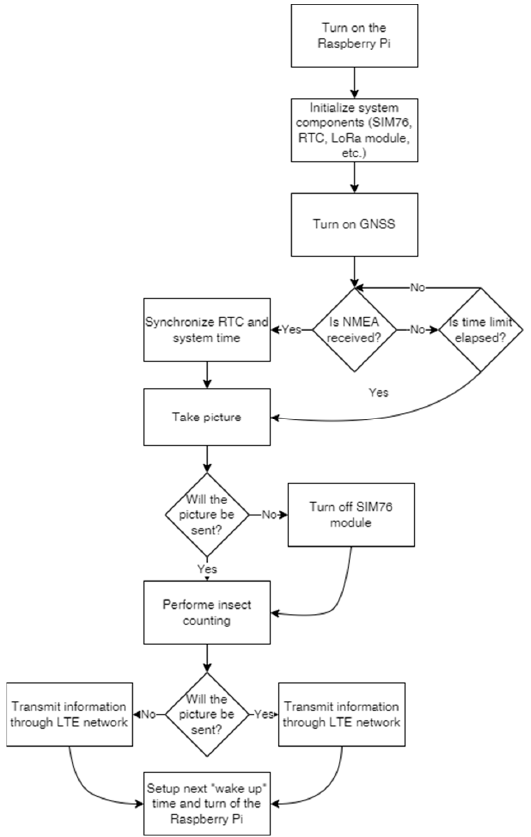
Figure 9. Flowchart of the software.